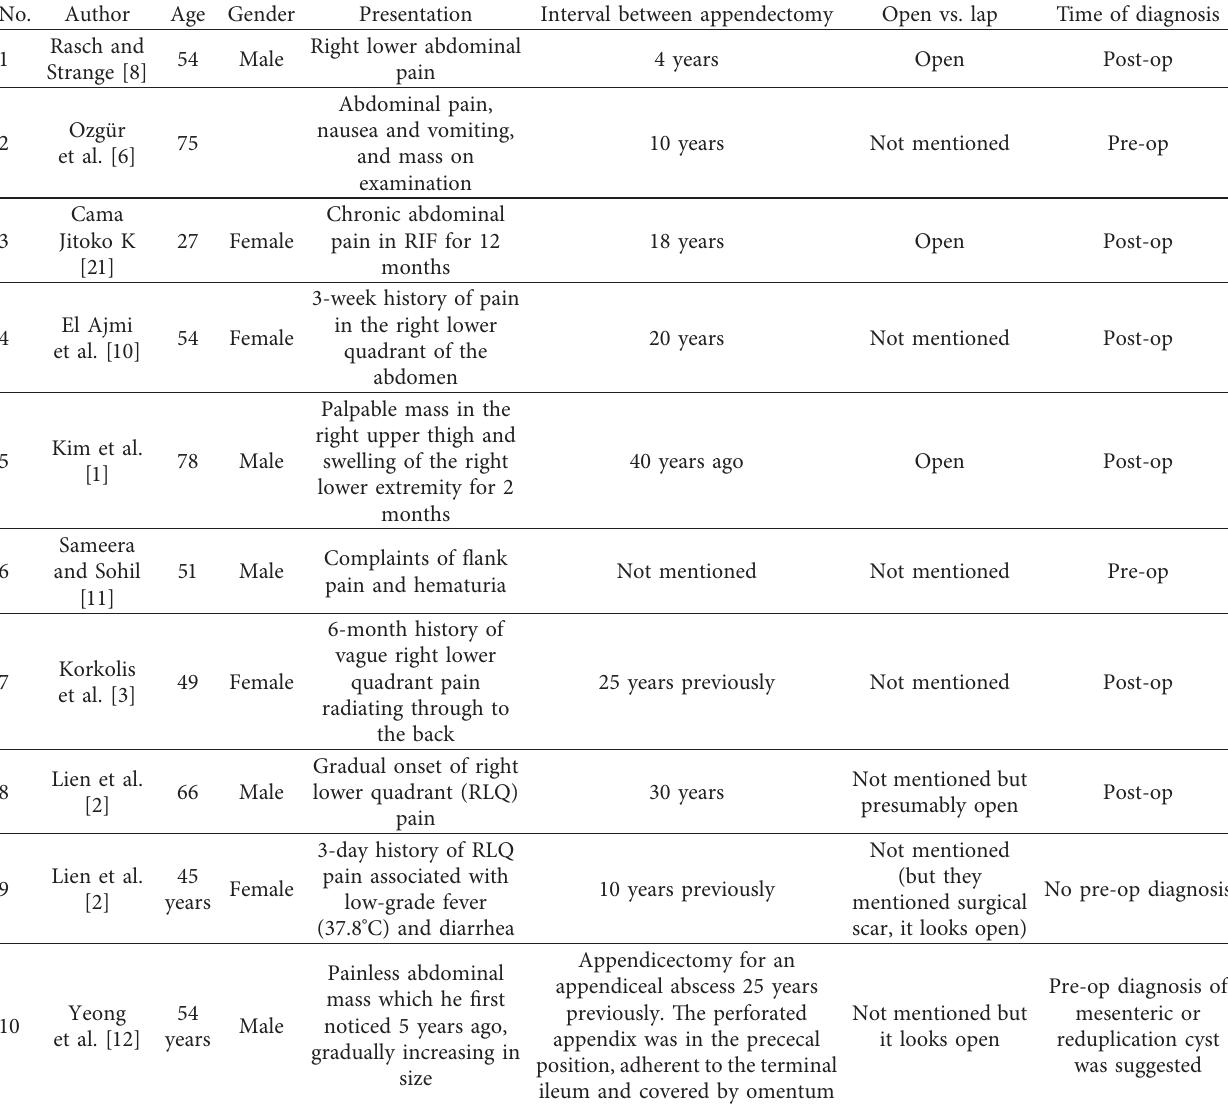
Table 1: Review of literature of appendiceal mucocele in stump